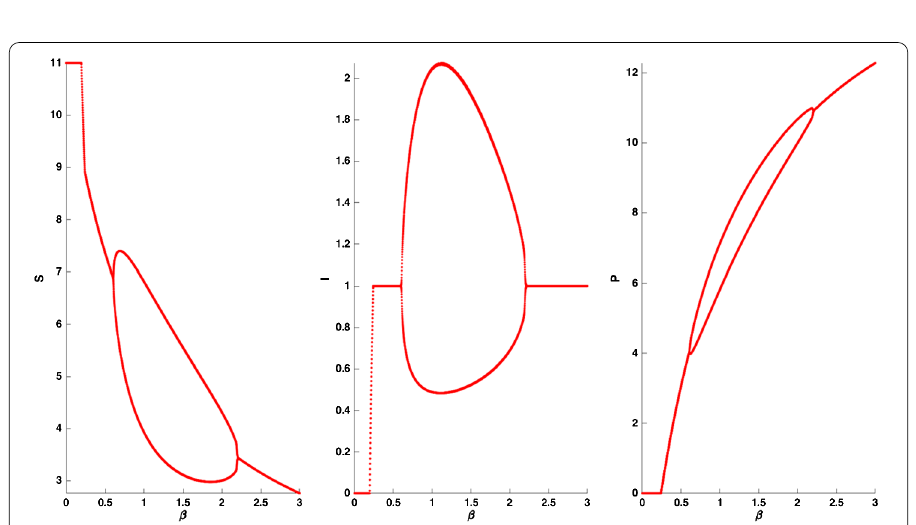
Figure 3 Bifurcation diagram of the fractional-order model (3) with respect to prey’s disease ( β ) when q = 1